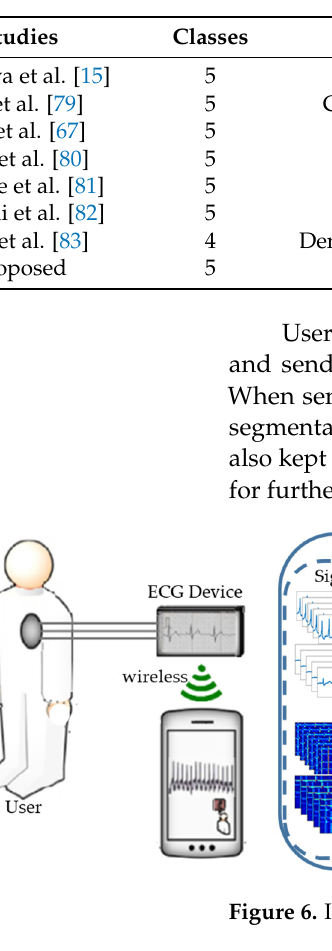
Table 20. Comparison between our approach and existing approaches to AAMI arrhythmia types.